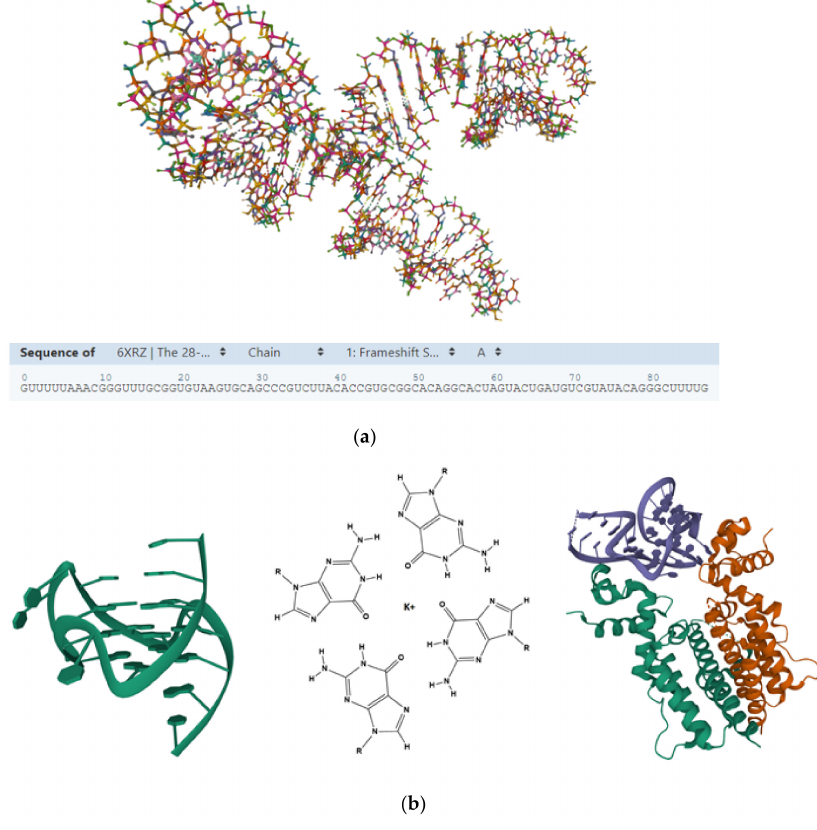
Figure 1. ( a ) The 28-kDa highly conserved FSE (frameshift stimulation element, PDB ID: 6XRZ https: //www.rcsb.org/3d-view/6XRZ/1 accessed on 4 February 2022) of the SARS-CoV-2 genome is an example of a potential candidate for targeting by small molecules and oligonucleotides as it is required for the balanced expression of SARS-CoV-2 proteins [73]. ( b ) An example of quadruple helical DNA (a monomeric parallel-stranded quadruplex in human VEGF promoter; PDB ID: 2M27 https: //www.rcsb.org/3d-view/2M27/0 accessed on 1 April 2022; left ) with a schematic representation of a G4 quartet ( middle ); and a complex between a nucleic acid aptamer (RNA-aptamer K1; purple) with its protein target (Tetracycline repressor protein; PDB ID: 6SY4 https://www.rcsb.org/3d-sequence/ 6SY4?assemblyId=1 accessed on 1 April 2022; right